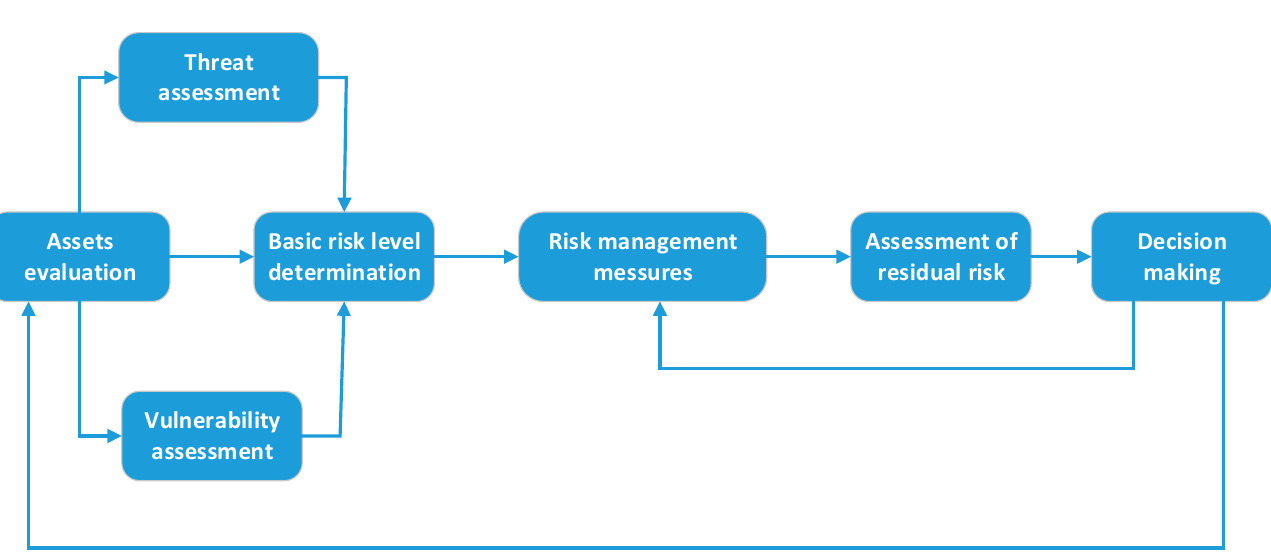
Figure 4. Data from PwC’s “The Global State of Information Security ® Survey 2016”. 12%7% 18% 26%28%